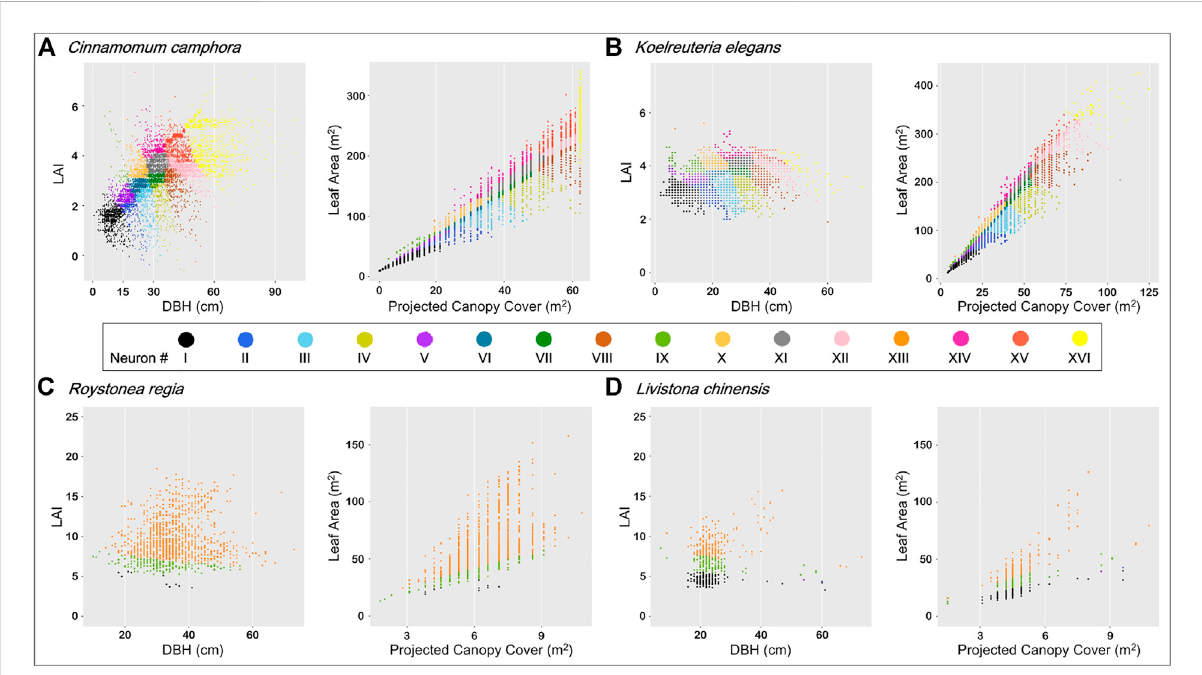
FIGURE 6 ScatterplotsofDBHtoLAI,andprojectedcanopycovertoleafareausingexamplesof (A) Cinnamomumcamphora (B) Koelreuteriaelegans , (C) Roystonea regia , and (D) Livistona chinensis